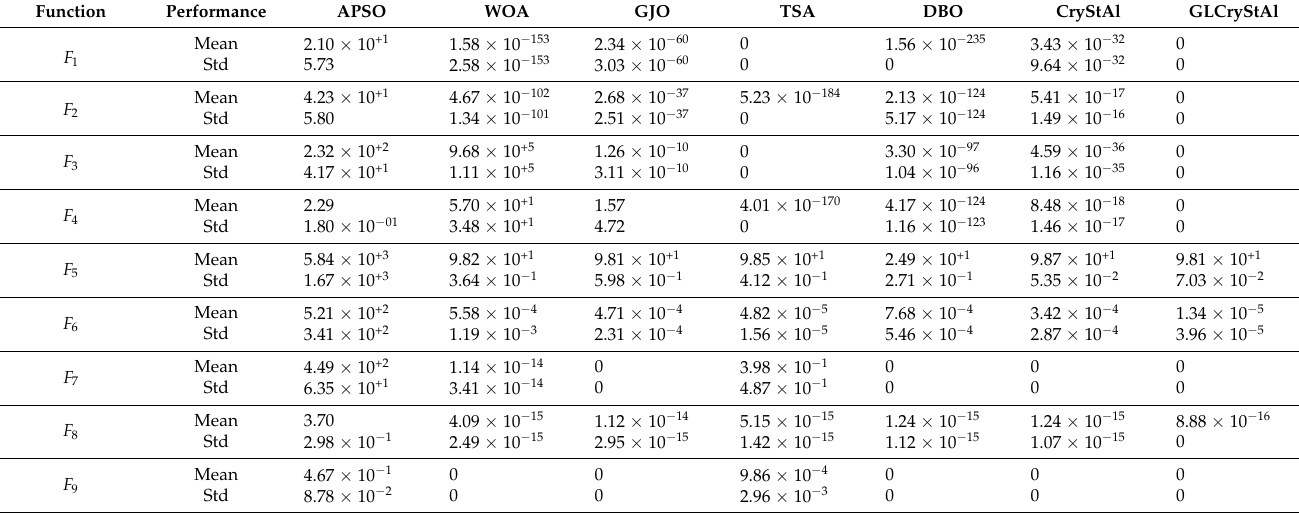
Table 4. Experimental results in 100